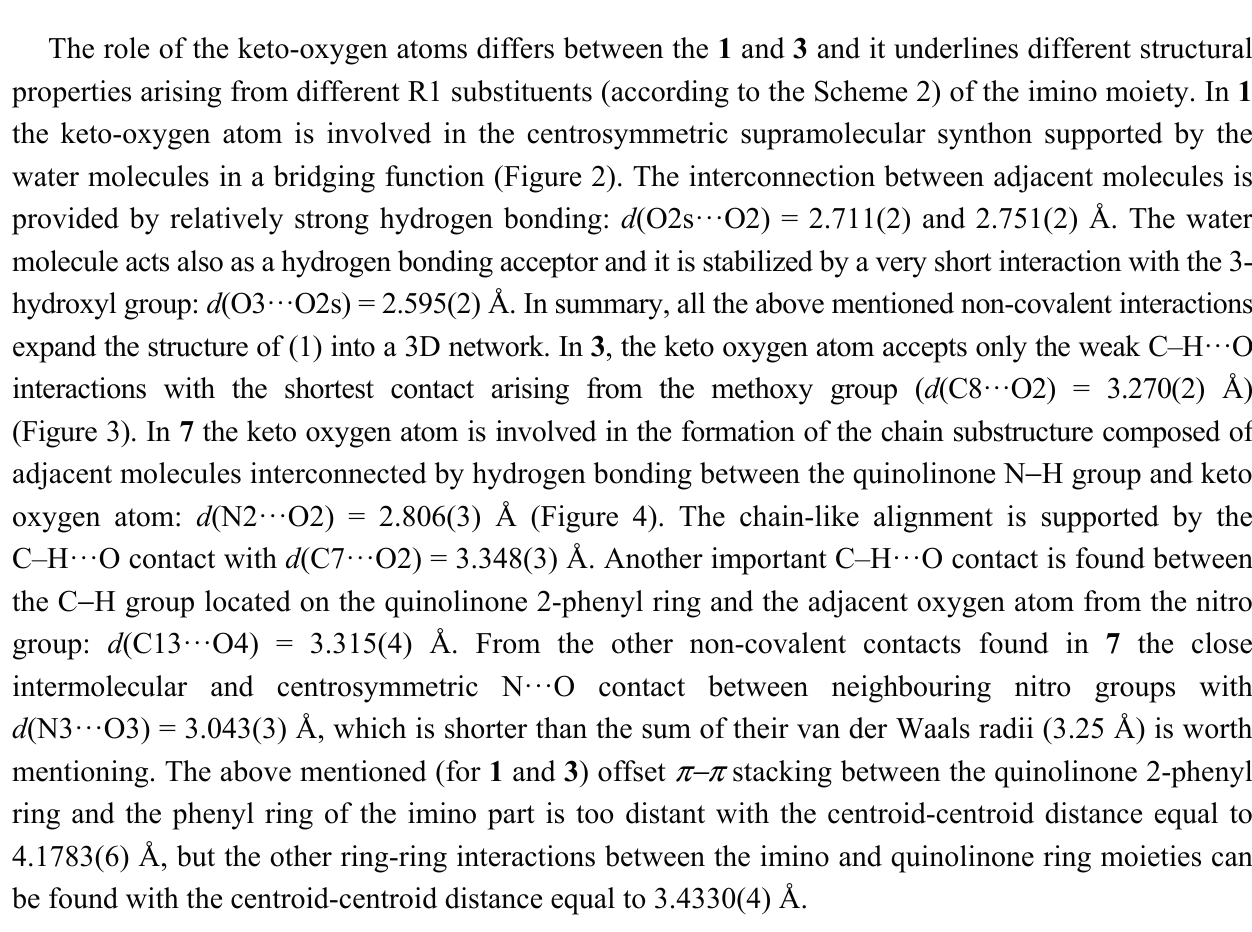
Figure 2. A part of the crystal structure of ( 1 ) showing the N − H···O, O–H···O and O − H···N hydrogen bonds (black dashed lines). The H–atoms not involved in the interactions are omitted for clarity. Symmetry codes: (i) − x, − 0.5 + y, 0.5 + z; (ii)